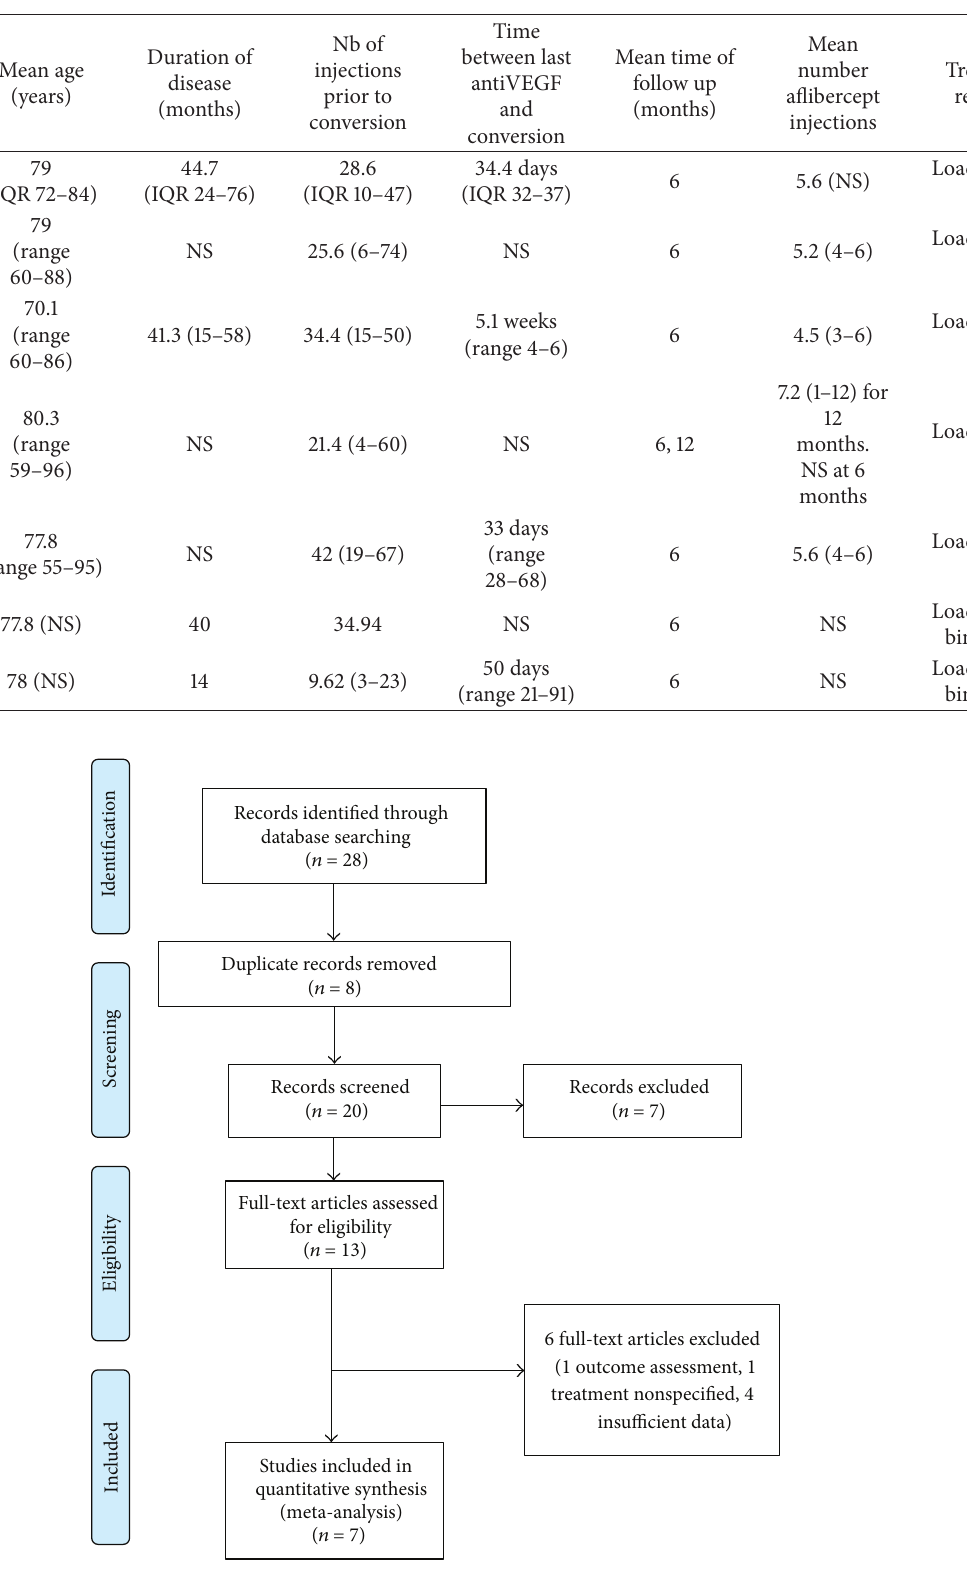
Figure 1: PRISMA flow diagram of study